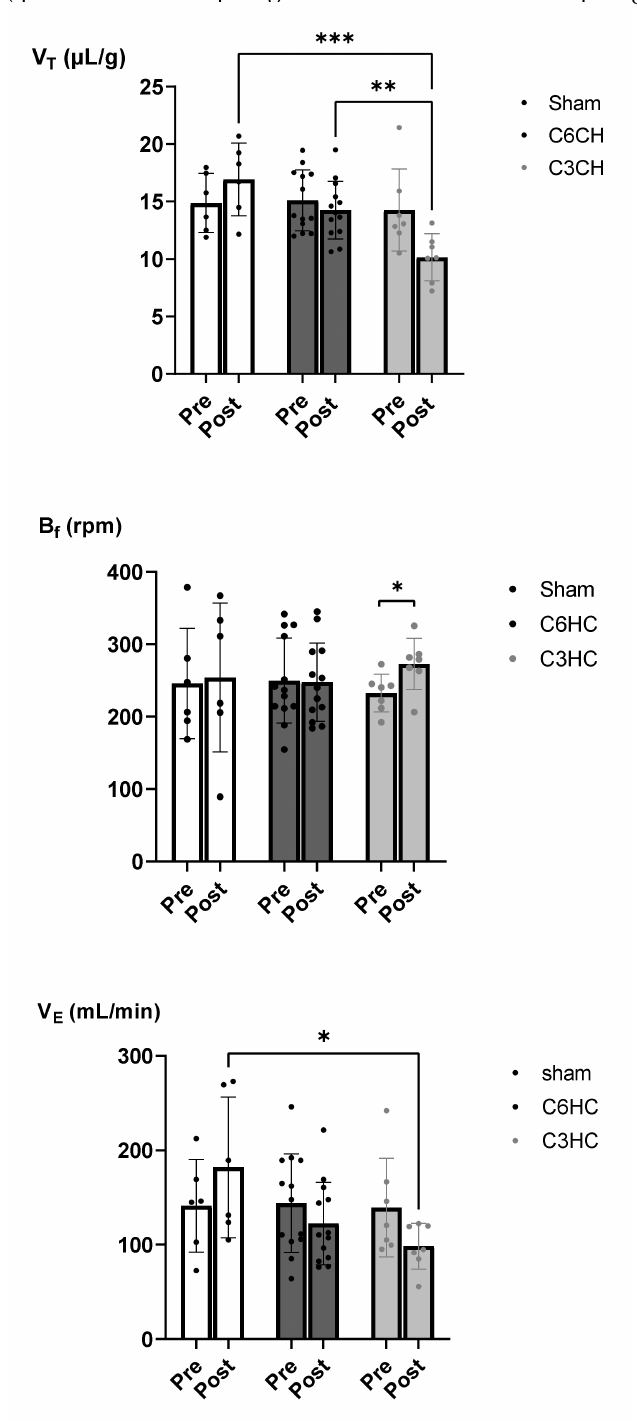
Figure 3. Respiratory pattern following C3 and C6 hemicontusions (HCs). Mean ± SD of tidal volume (V T ), breathing frequency ( B f ) and minute ventilation (V E ) before and 7 days after sham surgery, C6HC or C3HC. *** p < 0.001, ** p < 0.01, * p < 0.05. Bonferroni post hoc analysis: V T at 7 days post-C3HC was significantly lower than in sham and C6CH groups, and VE at 7 days post-C3HC was significantly lower than in